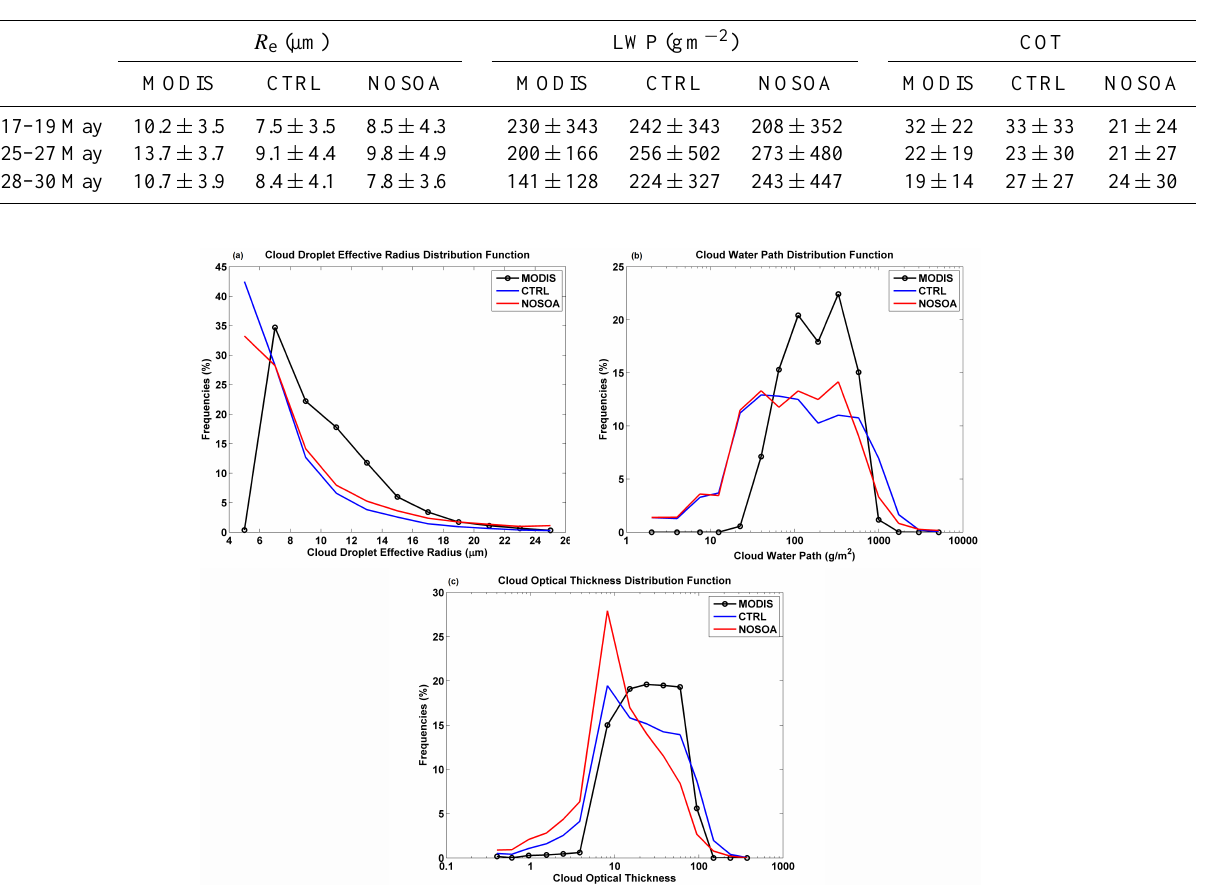
Figure 13. The 17–19 May 2008 averages of observed and simulated distribution function of droplet effective radius at cloud top (a) , liquid water path (b) , and liquid cloud optical thickness (c) . The black line represents the observations retrieved by MODIS, blue and red colours correspond to model predictions from the reference run (CTRL) and sensitivity test without SOA (NOSOA),